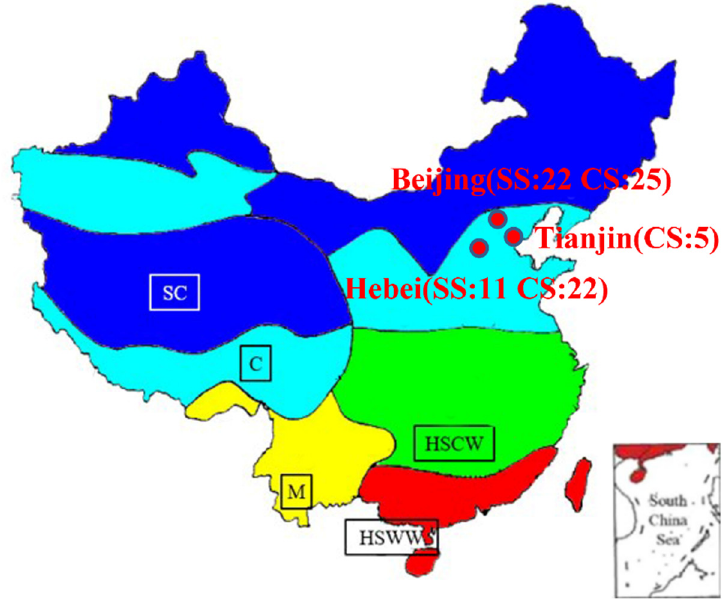
Figure 1. The climate zone distribution of China and location and quantity distribution of the monitored households. Beijing, Tianjin and Hebei were the cities and province investigated. SS is the split system and CS is the centralized system; C: cold region; SC: severe cold region; M: mild region; HSCW: hot summer and cold winter region; HSWW: hot summer and warm winter region.